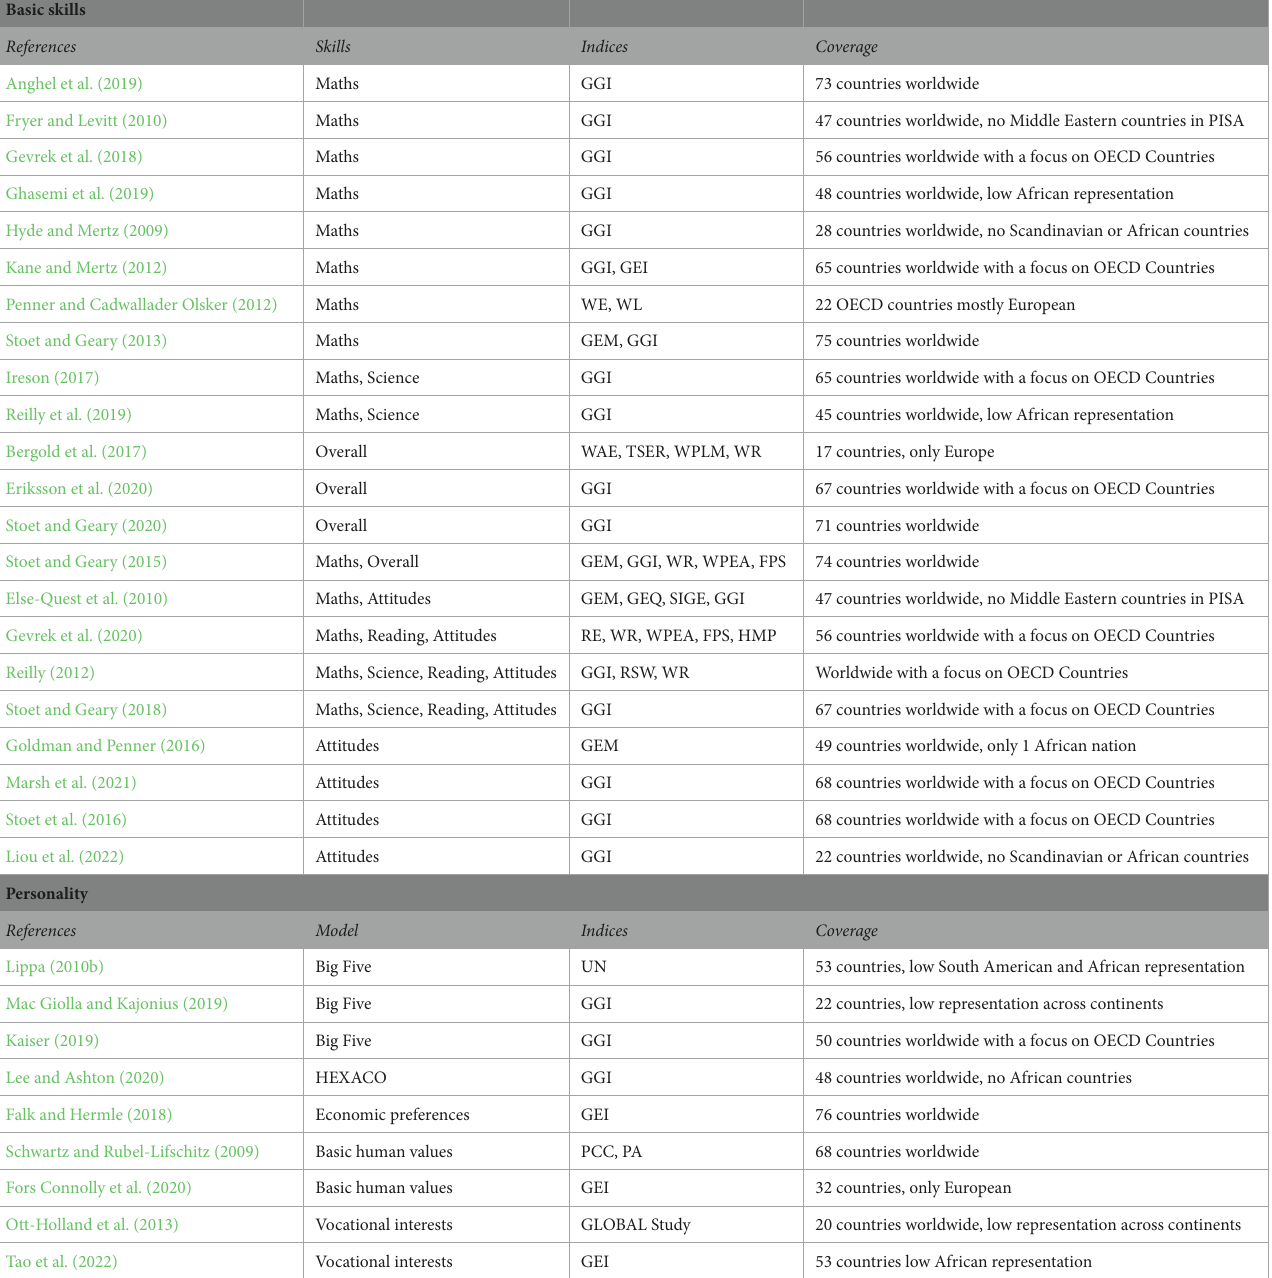
TABLE 4 Summary of the papers included in the